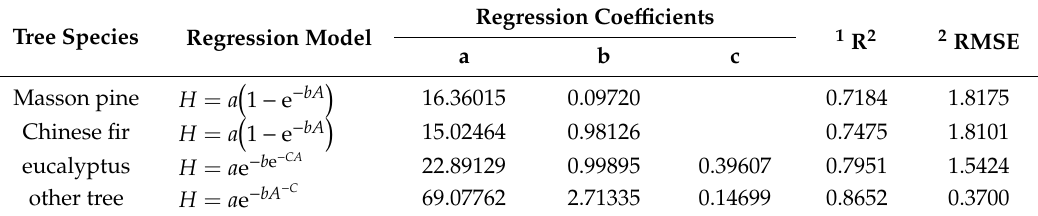
Table A1. Site index guidance curve model and regression coefficients.